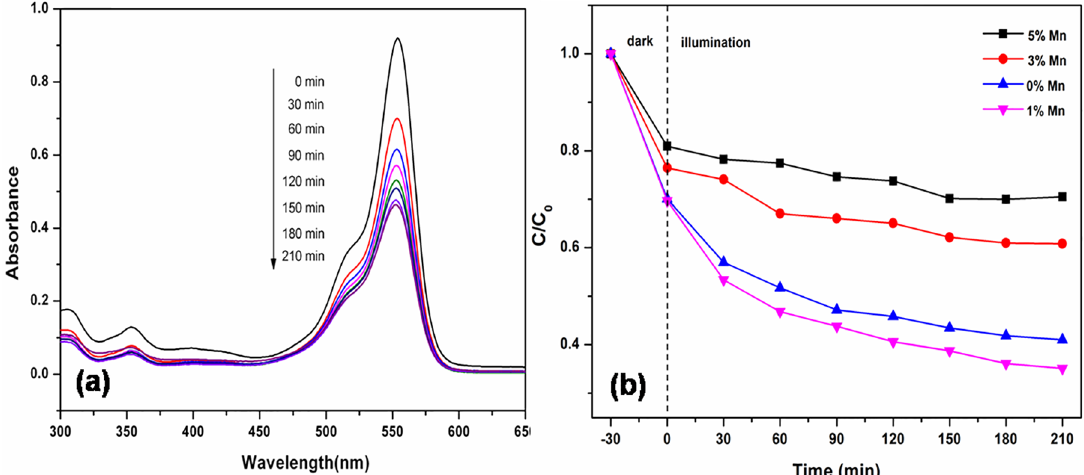
under ultraviolet light irradiation; (b) Degradation of 2